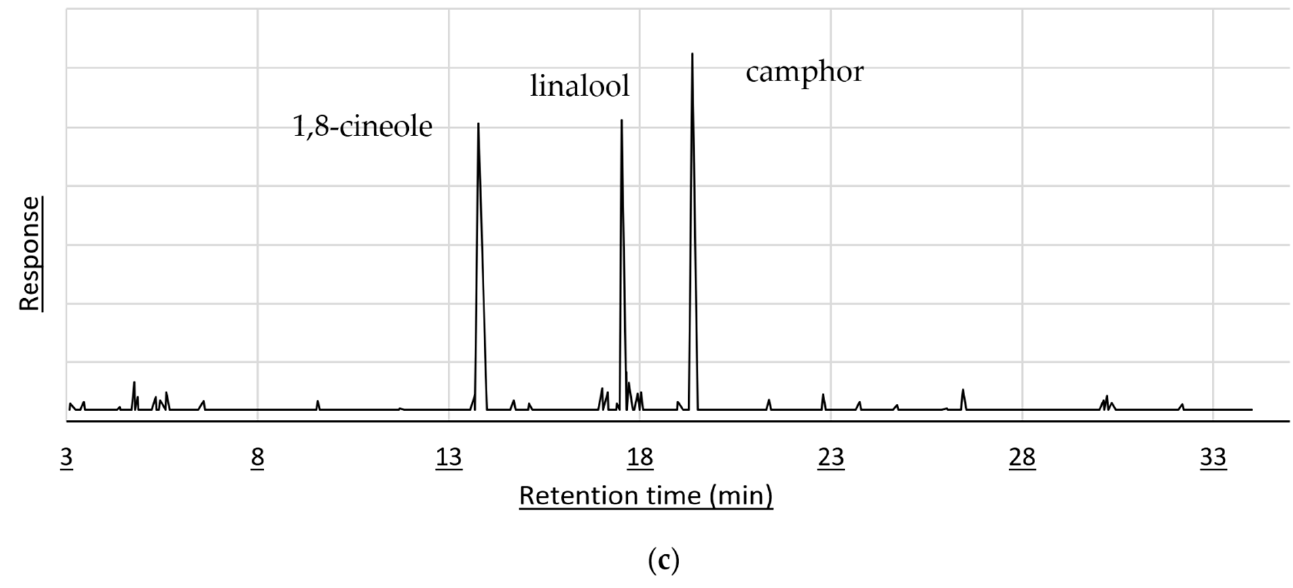
Figure 1. GC-MS chromatograms for lavender oil samples extracted using ( a ) steam distillation, ( b ) hydrodistillation, and ( c ) cellulase-assisted hydrodistillation.